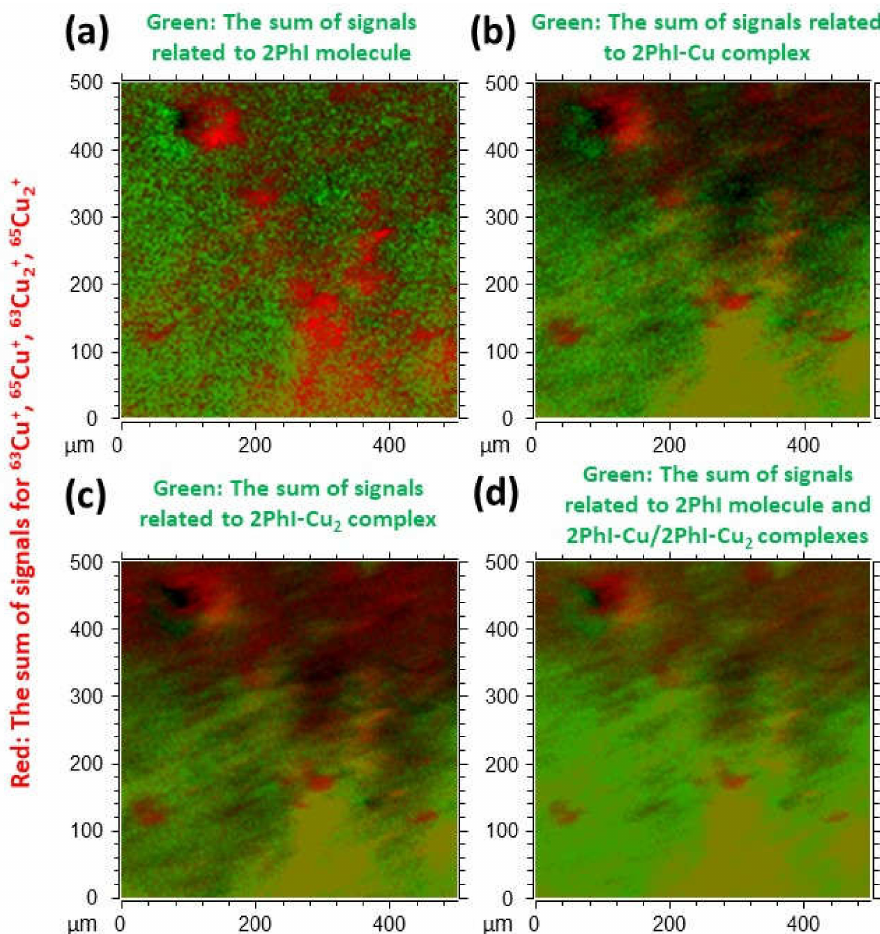
Figure 7. The spatial distribution of different species formed on the 2PhI-treated Cu: ( a ) 2PhI molecules, ( b ) organometallic complex with one Cu ion, and ( c ) organometallic complex with two Cu ions. subfigure ( d ) represents the sum of the signals for the 2PhI-related species in subfigures a – c . The red spots characterize the Cu